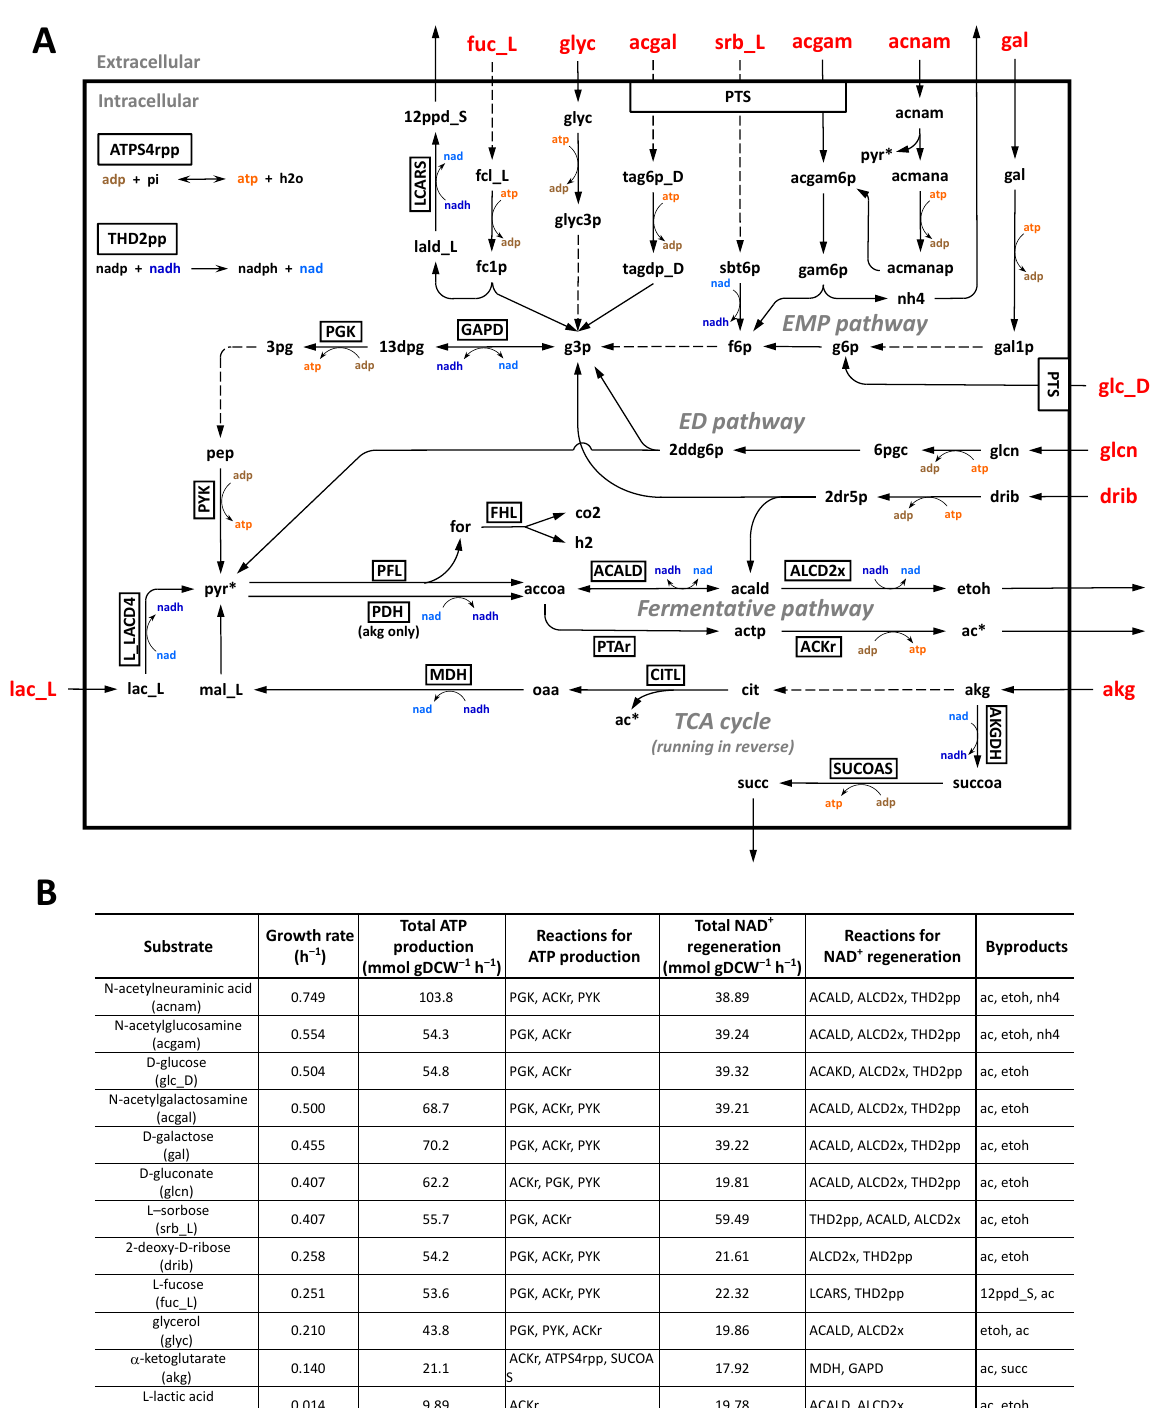
Figure 4. Model predictions of growth capability in the nutrient sources under anaerobic conditions. ( A ) Schematics of the predicted flux distributions. The nine carbon sources simulated are in red. Reactions are in the box. Arrows denote directions of the predicted metabolic fluxes, and dashed arrows indicate the multi-step reaction. Metabolites colored above arrows indicate cofactors (ADP, ATP, NAD, and NADH). Some metabolites (pyruvate and acetate) are duplicated on the map for clearer visualization and are labeled with an asterisk (*). ( B ) Summary of the simulation for the utilization of nine carbon sources. “Reactions for ATP production” and “Reactions for NAD + regeneration” are reactions responsible for >95% of total ATP production and total NAD + regeneration, respectively, in descending order. Abbreviations are given in Supplementary Table S4. For flux balance analysis (FBA) under anaerobic conditions, the upper limits of oxygen and each of the carbon sources were set to zero and 20 mmol gDCW − 1 h − 1 ,